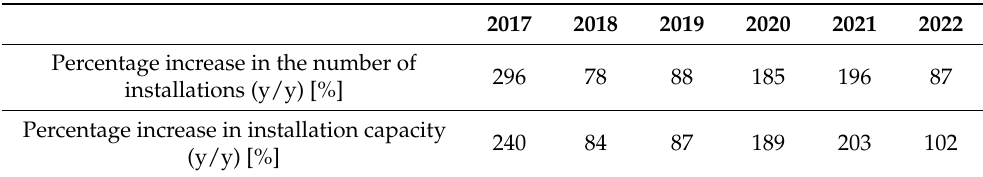
Figure 3. Number and total power of installation connected by dso in 2016–2022, based on [32]. The percentage increase in capacity and number of installations (year on year) is presented in Table 1. Table 1. Percentage increase in power and number of installations.